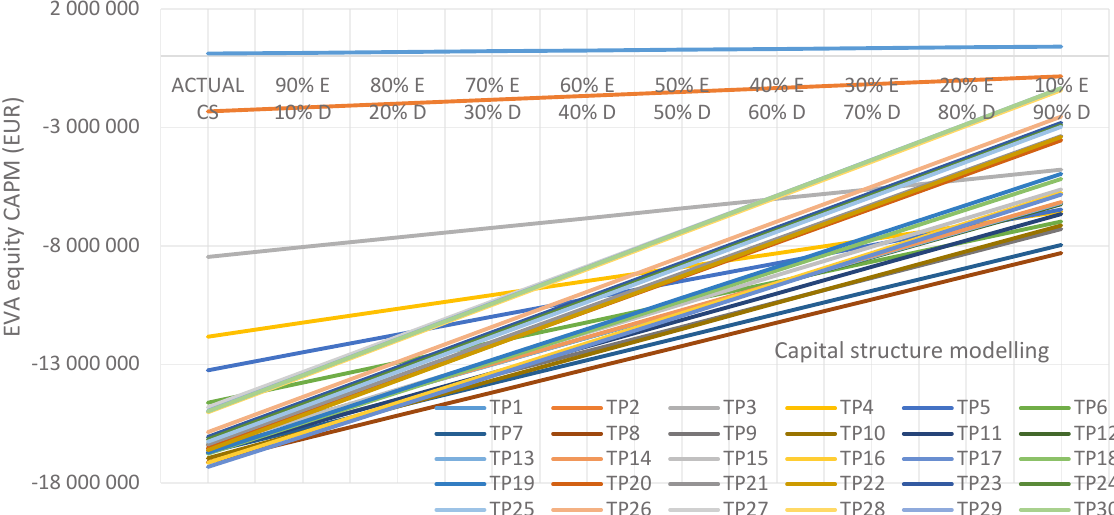
Figure 3. Development of the EVA equity indicator following the change in capital